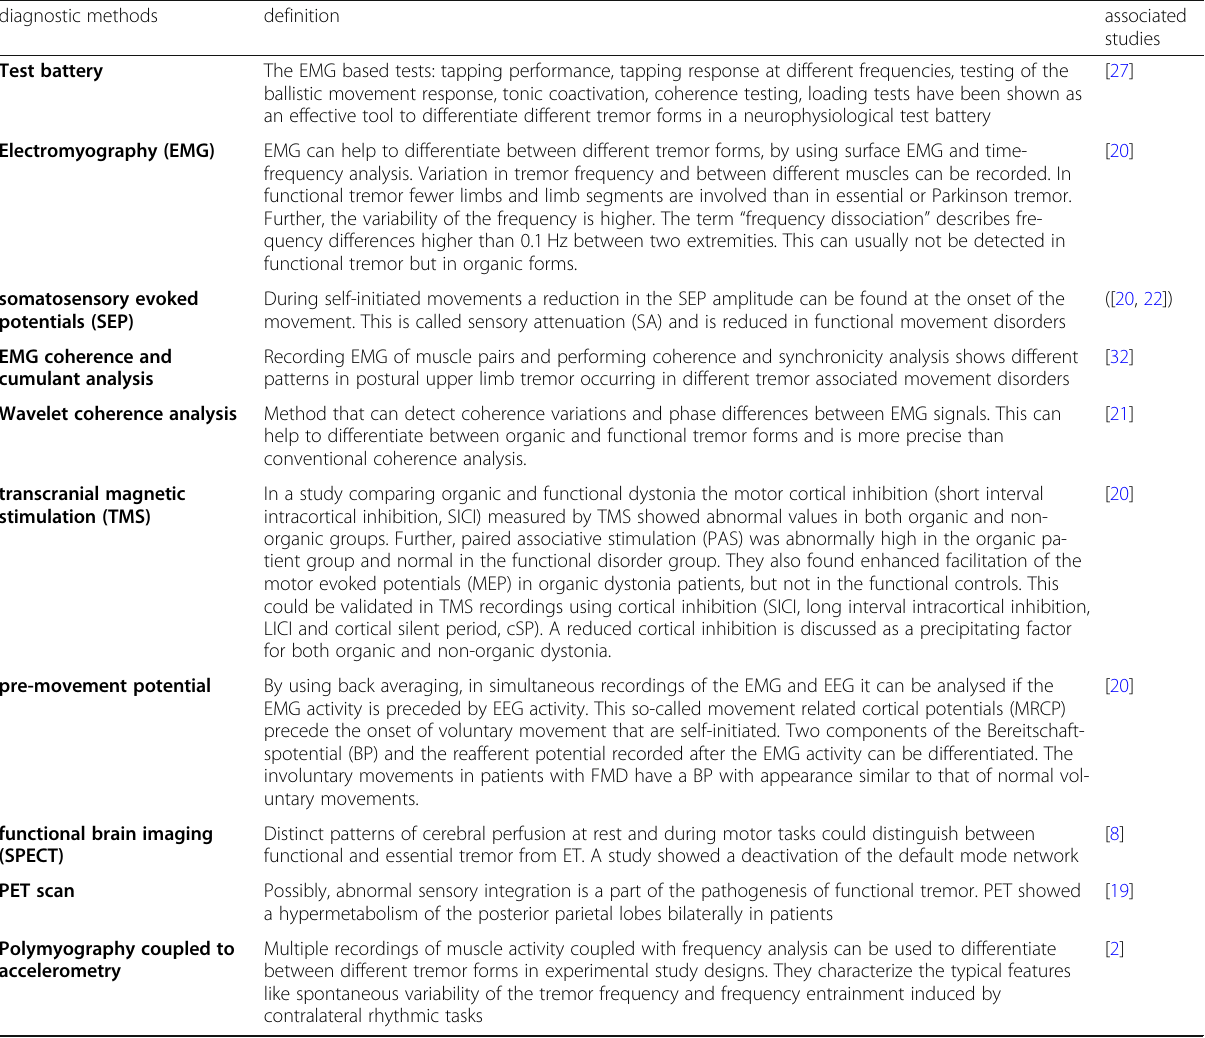
Table 2 Listing of diagnostic methods in functional